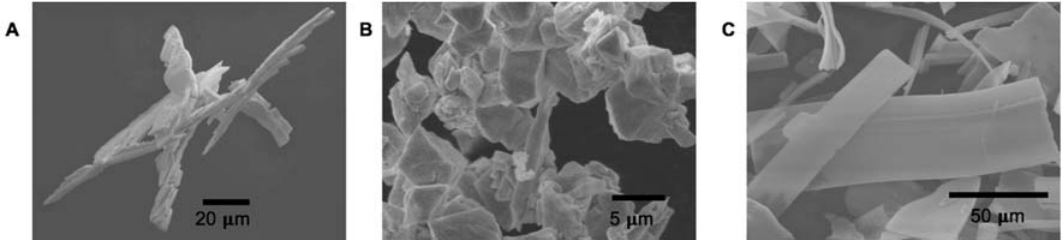
Figure 3. SEM images for fcc –Ir 0.50 Pt 0.50 ( A ), fcc –Rh 0.66 Pt 0.33 ( B ) and fcc –Rh 0.50 Pd 0.50 ( C ) binary